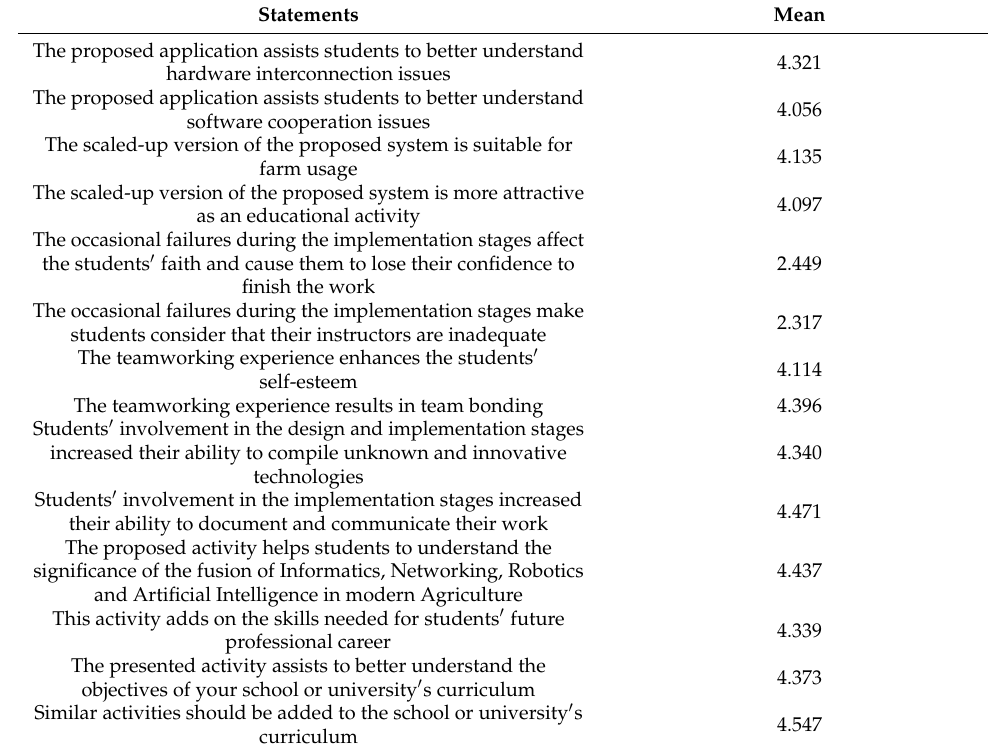
Table A1. Statements used in the evaluation form to measure participants’